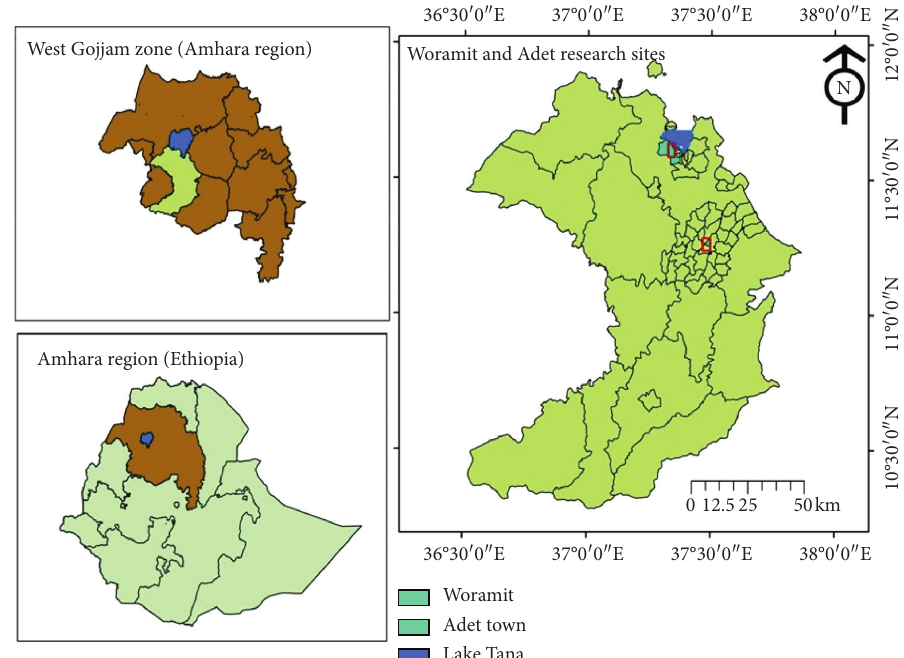
Figure 1: Map of the experimental